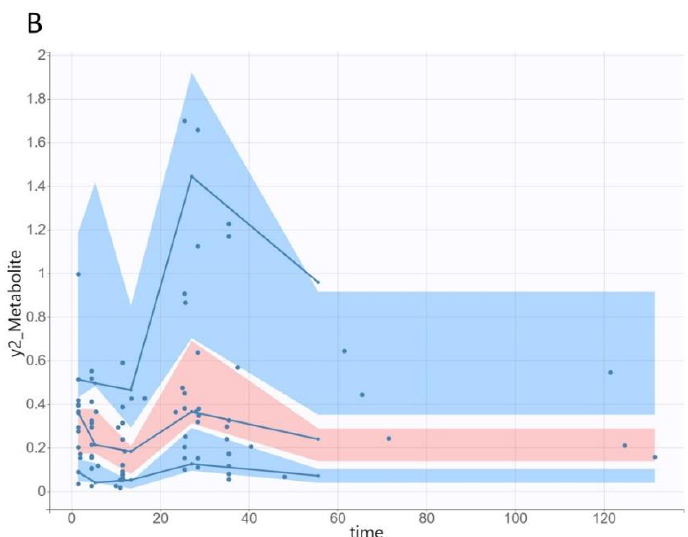
Figure 4. Visual predictive check (shaded areas) and observed data (circles) of ciprofloxacin ( A ) and desethylene ciprofloxacin ( B ) serum concentration versus time for the final model. Solid blue lines represent the 10th, 50th and 90th percentiles of the observed data. Shaded regions represent the 90% confidence interval around the 10th (lower blue region), 50th (pink region) and 90th (upper blue region) percentiles of the simulated data.